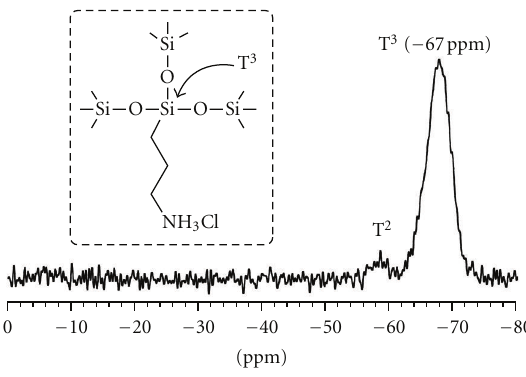
Figure 3: Solid-state 29 Si NMR spectrum of PSQ-NH 3+ Cl −